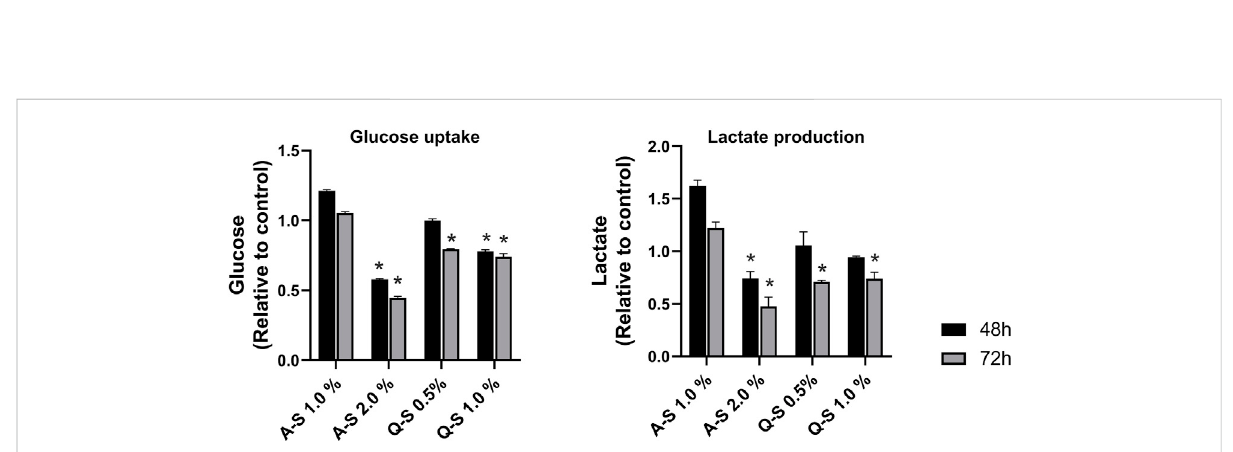
FIGURE 4 Glucose uptake (leftgraph)and lactate production(right graph) byMDA-MB-231cells treated with Viscum album summer mother tinctures for 48 h(blackbars)and72 h(greybars)ofthetreatmentwithA-S(1.0%and2.0%v/v)andQ-S(0.5%and1%v/v).Plottedvaluesarerelativetothecontrol (ethanol vehicle) at the same concentration of the summer mother tinctures, * p < 0.05 calculated by nonparametric Mann-Whitney test. Legend symbols: V.album subsp. abietis growingon Abiesalba insummer(A – S); V.album subsp. album growingon Quercuspetraea insummer(Q – S).